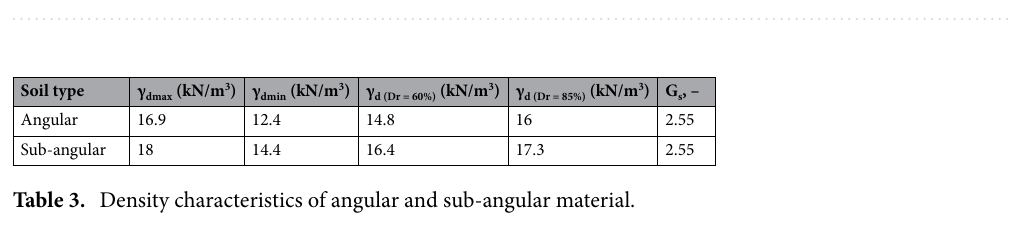
Figure 3. The Micro-Deval machine used in the study.